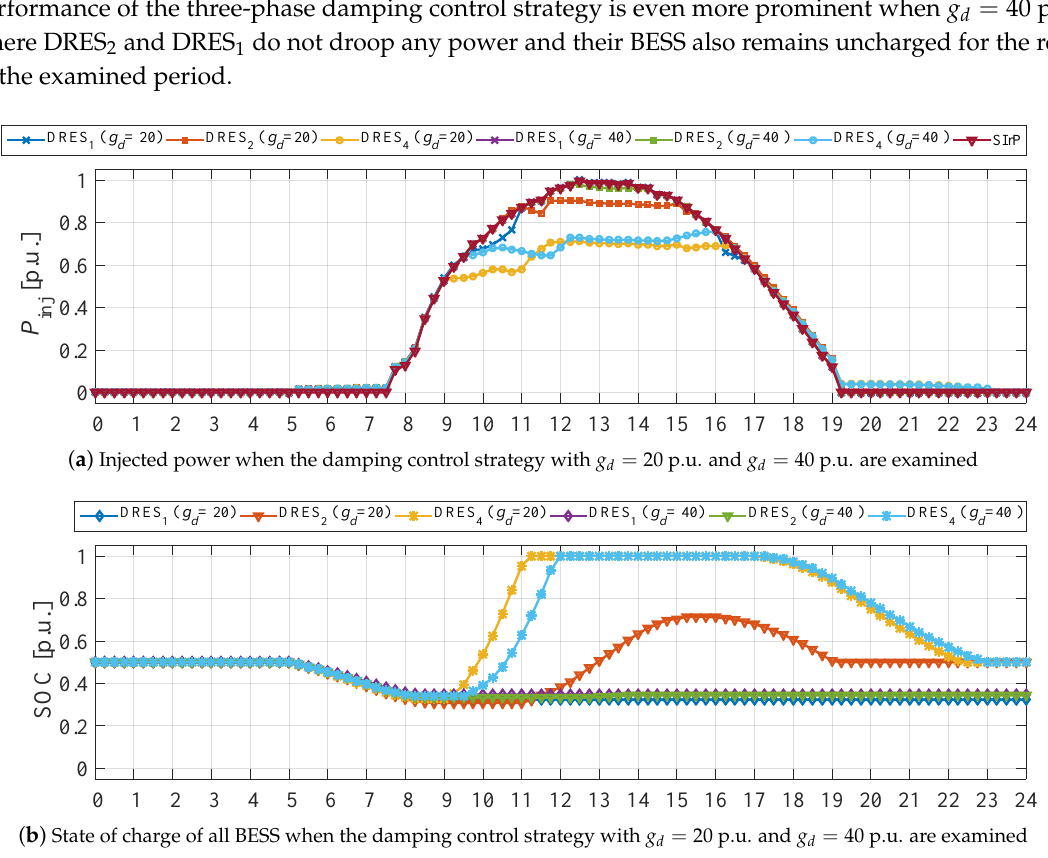
Figure 8. Injected power and SOC of all DRES when the the three-phase damping control strategy is examined (C1S4 and